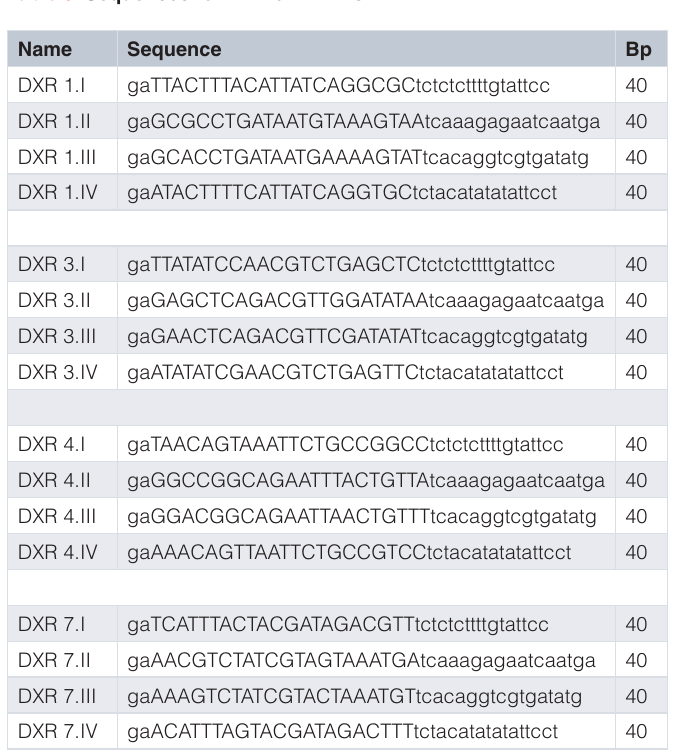
Table 3. Sequences for DXR